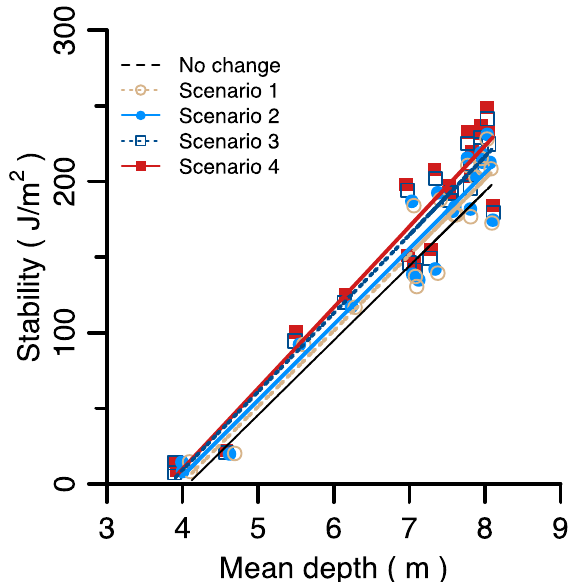
Figure 9. Relationships between mean annual (January to December) mean depth versus mean annual Schmidt stability for all climate projections in all years. The regression equation for the reference run with no change (S NC = − 200.59 + 49.25 × Z ) gives an Adj. R 2 = 0.91 ( p < 0.001). Stability was higher for any given depth in warmer scenarios—Scenario 1 (S Scenario1 = − 199.52 + 50.14 × Z ; Adj. R 2 = 0.92), Scenario 2 (S Scenario2 = − 195.15 + 50.10 × Z ; Adj. R 2 = 0.92), Scenario 3 (S Scenario3 = − 198.14 + 51.82 × Z ; Adj. R 2 = 0.93), Scenario 4 (S Scenario4 = − 204.05 + 53.46 × Z ; Adj. R 2 = 0.93); all p < 0.001.